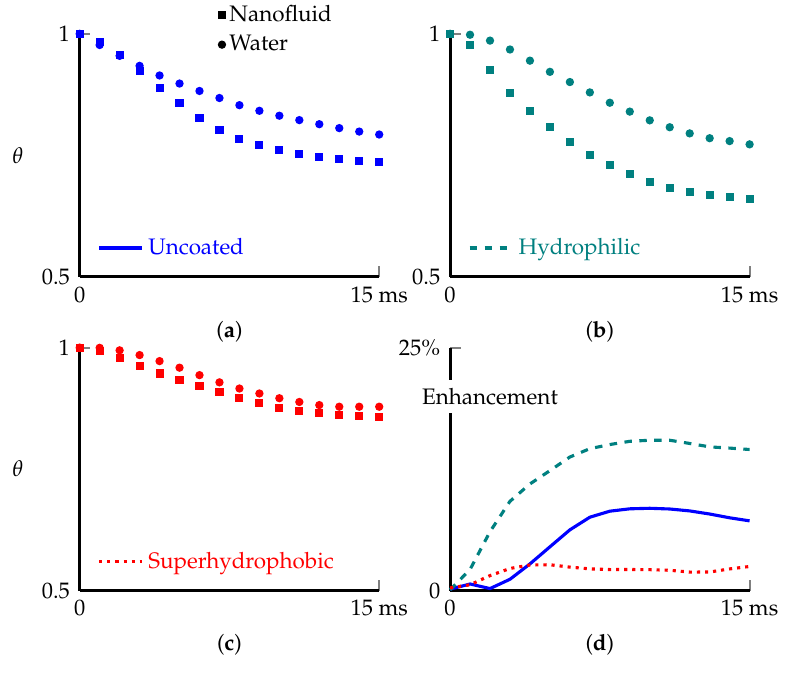
Figure 8. Non dimensional wall temperature decrease due to the impingement of a nanofluid droplet (0.5 wt.%) and a water droplet. Three substrates are considered: ( a ) uncoated, ( b ) Hydrophilic, ( c ) Superhydrophobic. ( d ) Cooling enhancement obtained using nanofluids with respect to water. Graphs are reconstructed from